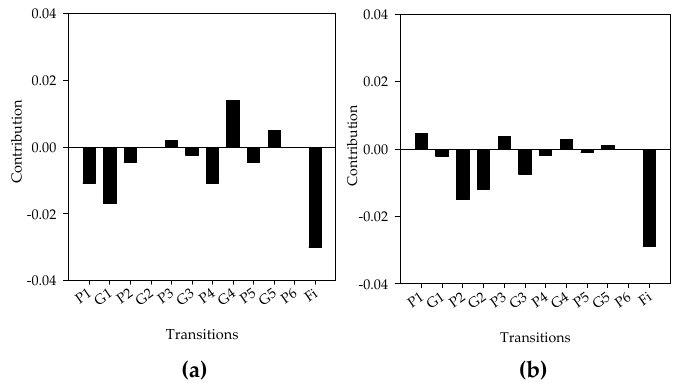
Figure 3. Life table response experiment (LTRE) analysis on the coffee berry borer Hypothenemus hampei treated with tetracycline (0.1% w/v) compared with control (without antibiotics) and penicillin (0.1% w/v) treatments. The bars show the contribution of each life cycle transition to the reduction in population growth rate ( λ ) when comparing diets. ( a ) Control vs. Tetracycline and ( b ) Penicillin vs. Tetracycline. Gi : probability of transition between stages, Pi : probability of surviving and remaining in the same stage, Fi : fertility of adult females. (1) Eggs, (2) Larvae, (3) Pre-pupae, (4) Pupae, (5) Juveniles, (6)